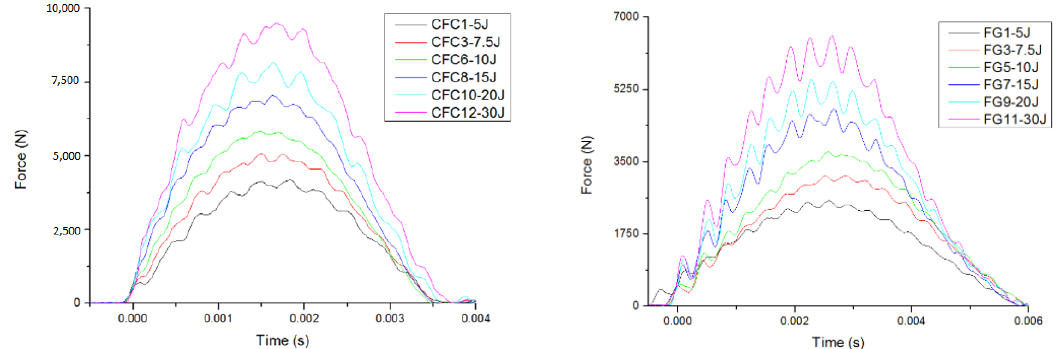
Figure 3. Force time history for Carbon ( left ) and Glass ( right ) fibers tested.